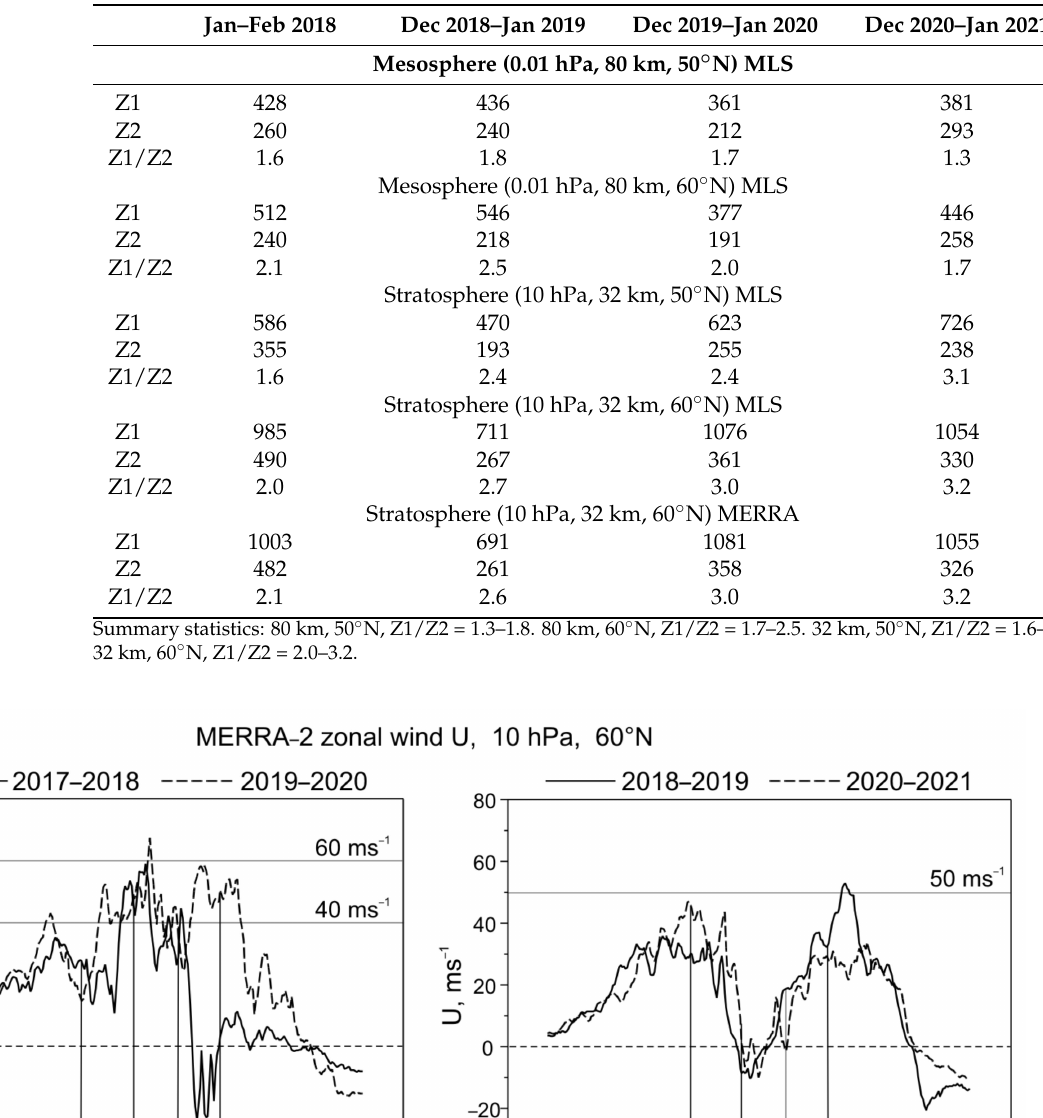
Table A1. The two-month mean amplitudes of wave 1 (Z1, m) and wave 2 (Z2, m) and ratio between them (Z1/Z2, in bold) in winters 2018–2021 in the stratosphere (10 hPa, 32 km) and mesosphere (0.01 hPa, 80 km).